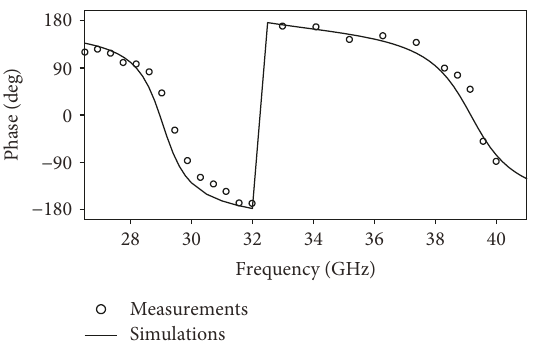
Figure 15: Comparison between measured and simulated phase curve vs.